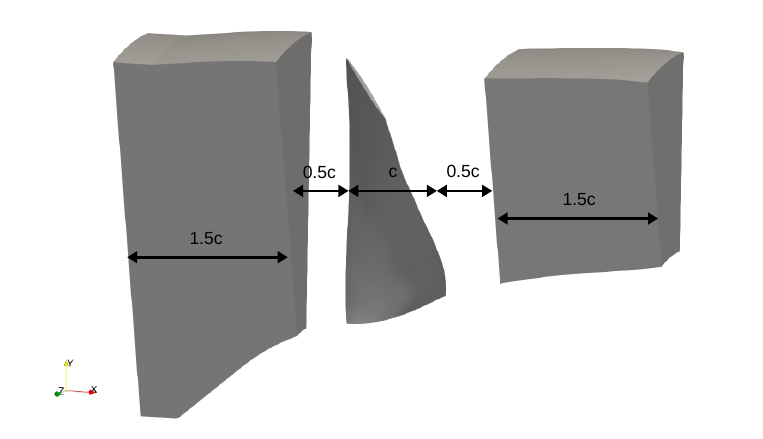
Figure 12. Volumes used for pressure